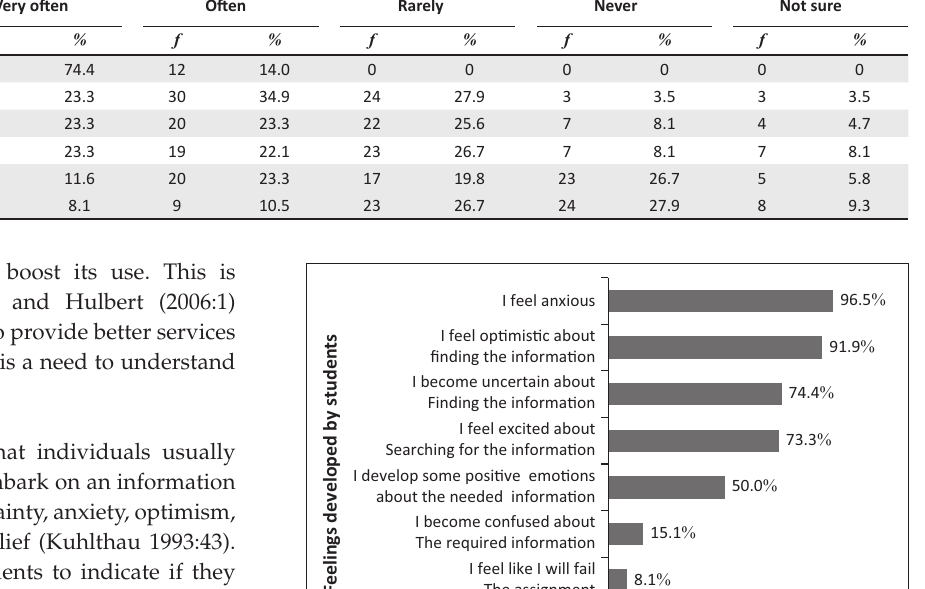
TABLE 1: Information-seeking seeking strategies. Information seeking